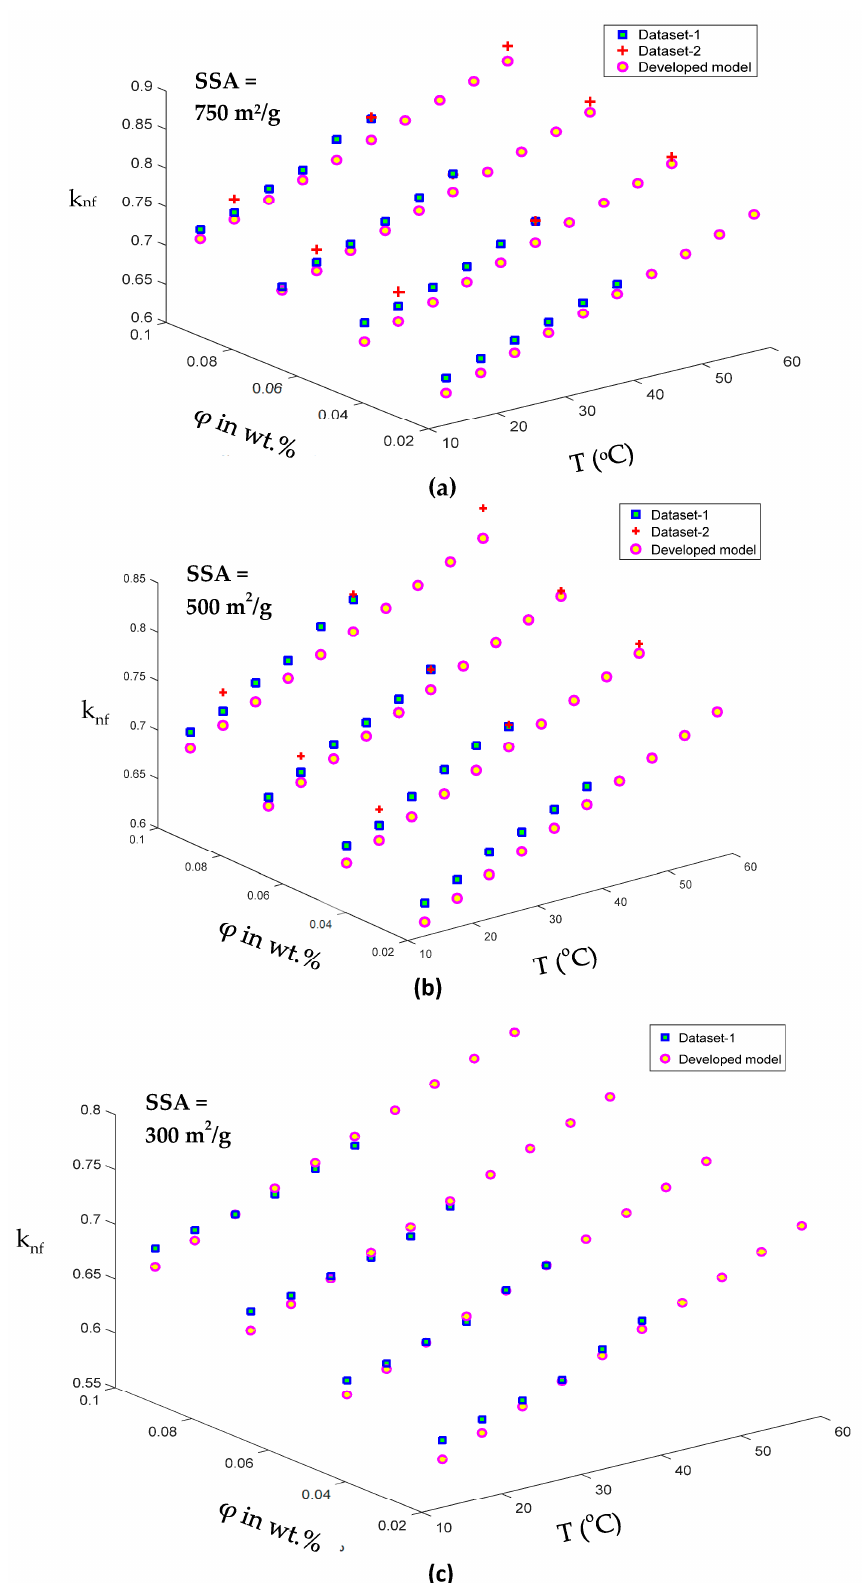
Figure 3. Comparison of the predictions of Equation (2) against the experimental data by [14] and [16] for GNP specific surface areas of ( a ) 750 m 2 /g, ( b ) 500 m 2 /g, and ( c ) 300 m 2 /g.